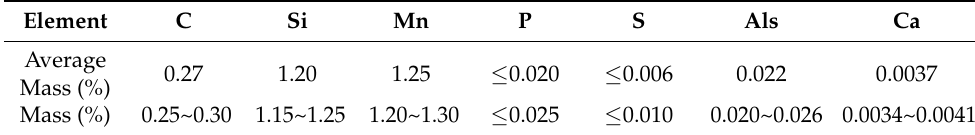
Table 1. Average composition of 27SiMn